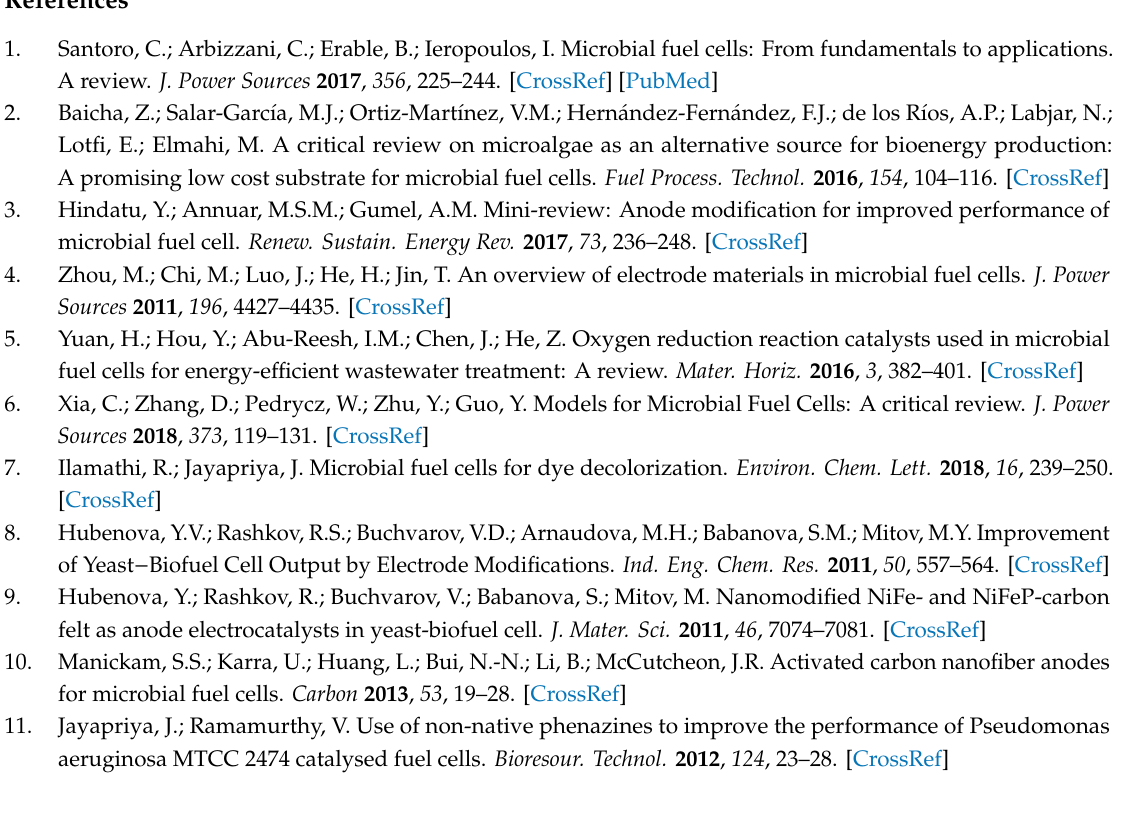
Figure S1: Cyclic voltammograms of the investigated materials in non-inoculated cultivation medium, Table S1: Experimental XRD peaks compared to ICDD reference data, Table S2: Open circuit potentials before and after inoculation with